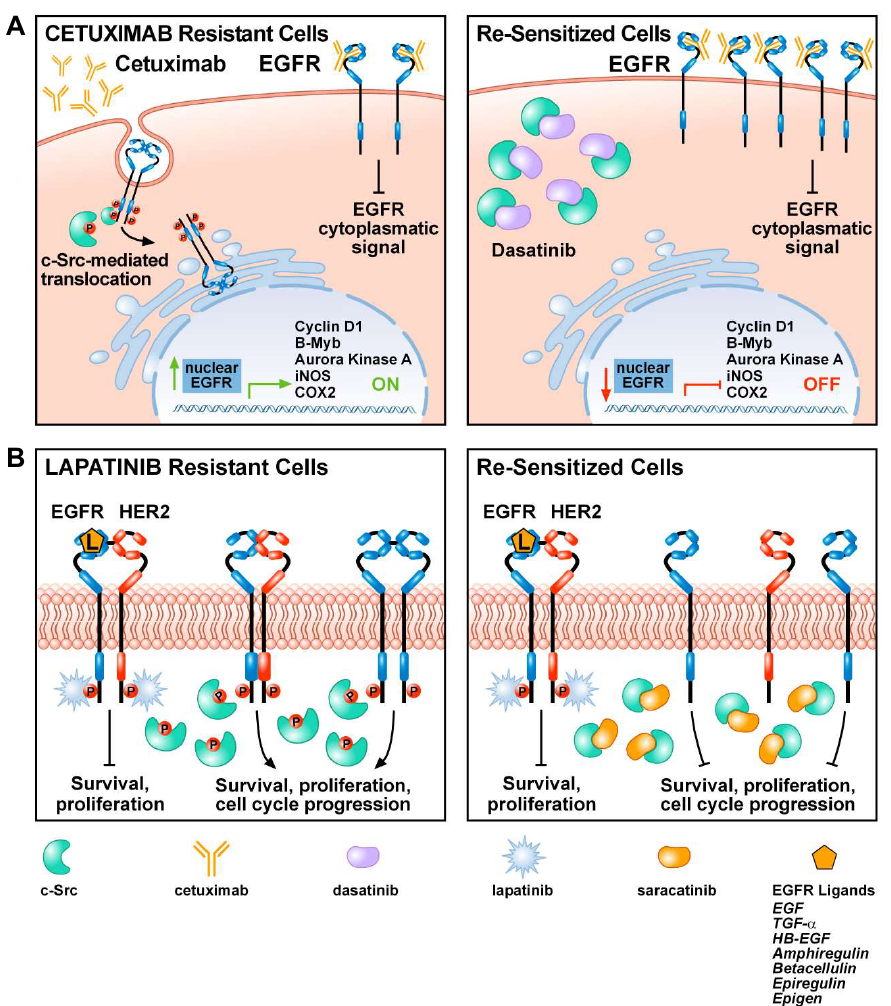
Figure 1. c-Src mediates mechanisms of resistance to epidermal growth factor receptor (EGFR) inhibitors: ( A ) Cetuximab resistant cells express high levels of c-Src protein. Although cetuximab might abrogate EGFR signaling from the plasma membrane, most EGFRs are translocated to the nucleus in a Src-dependent manner. Here, EGFR activates proliferative signals by modulating Cyclin D1, B-myb, Aurora kinase K, INOS, COX2 (left panel). c-Src inhibition with dasatinib reduces EGFR nuclear translocation, re-sensitizing cells to cetuximab treatment (right panel). ( B ) In lapatinib resistant breast cancer cells, c-Src over-expression induces EGFR / HER2 heterodimers activation, bypassing the lapatinib-dependent inhibition of survival and proliferation pathways. In particular, c-Src phosphorylation of EGFR Y845 boosts down-stream signaling pathways to EGFR homo and heterodimers activation (left panel). Cell treatment with c-Src inhibitor saracatinib restores lapatinib sensitivity and overcome EGFR and its related oncogenic pathways activation (right